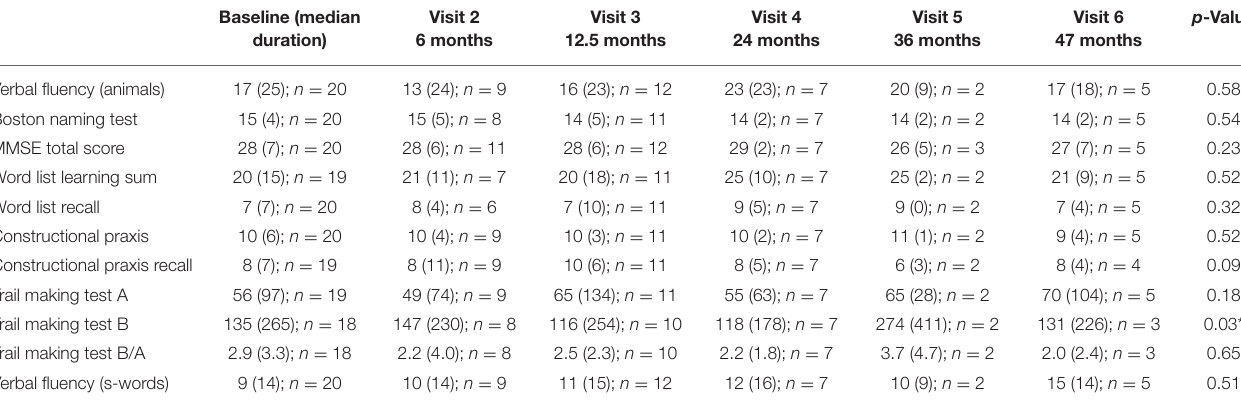
TABLE 2 | Summary of the CERAD neuropsychological plus battery subitem results over